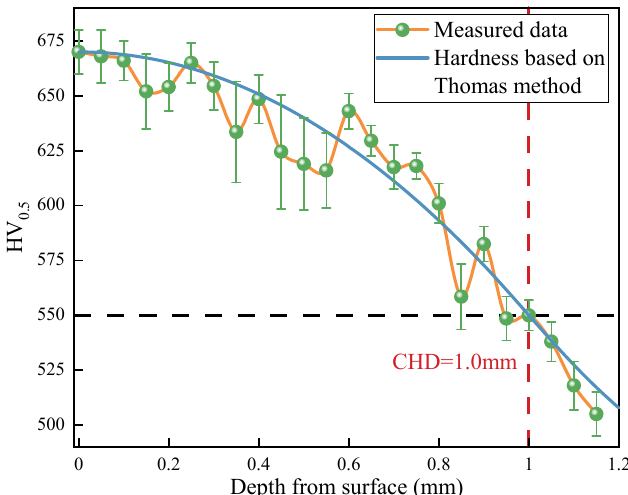
Figure 8. The measured hardness data and the empirical hardness curve.